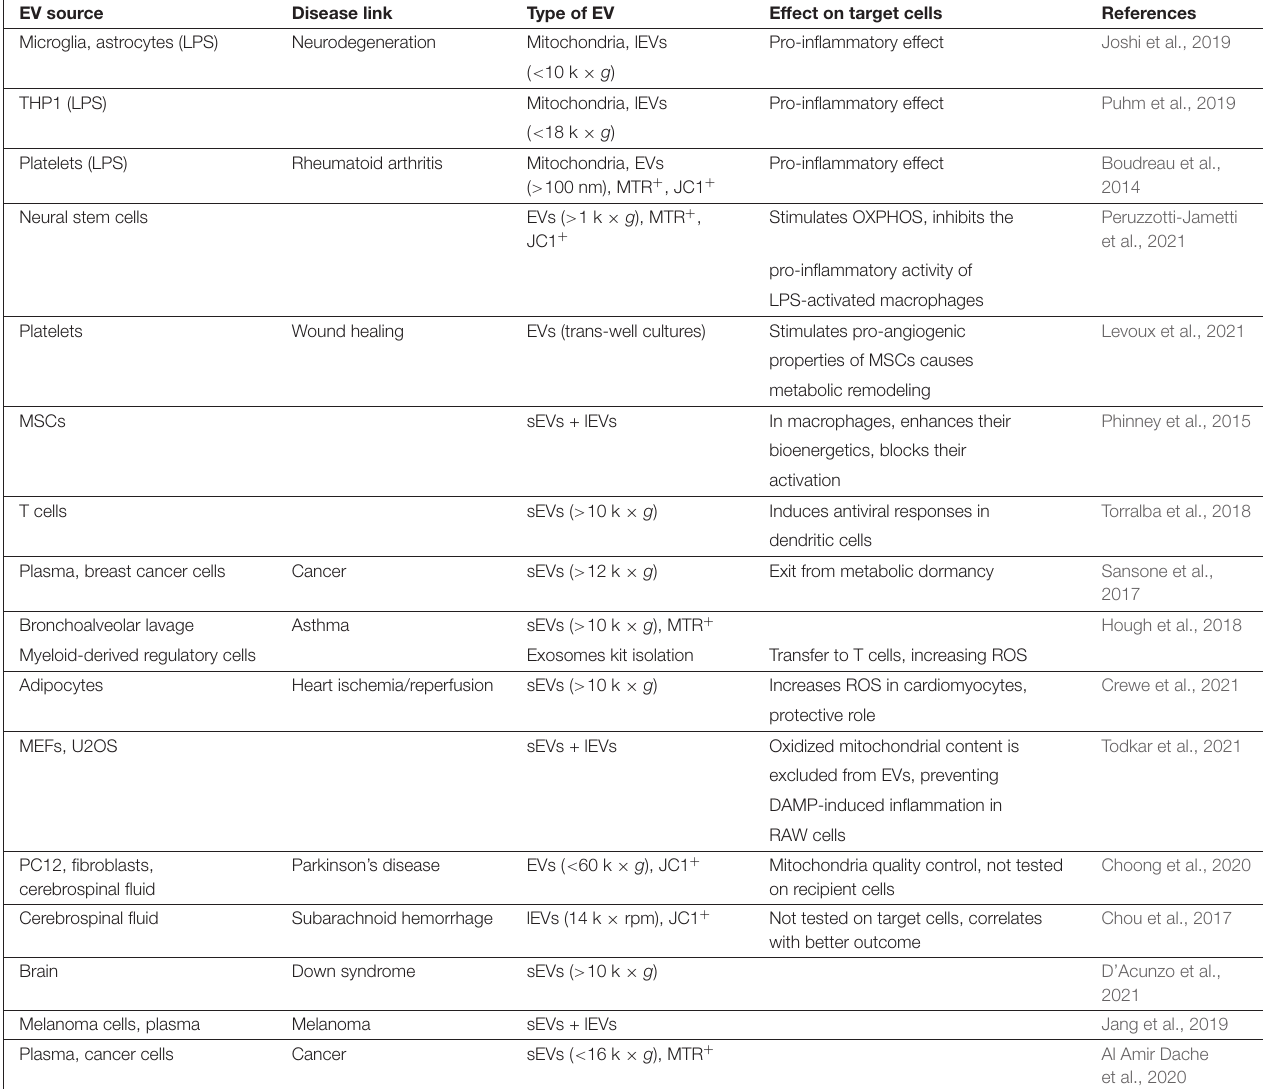
TABLE 1 | Nature and properties of mitochondrial